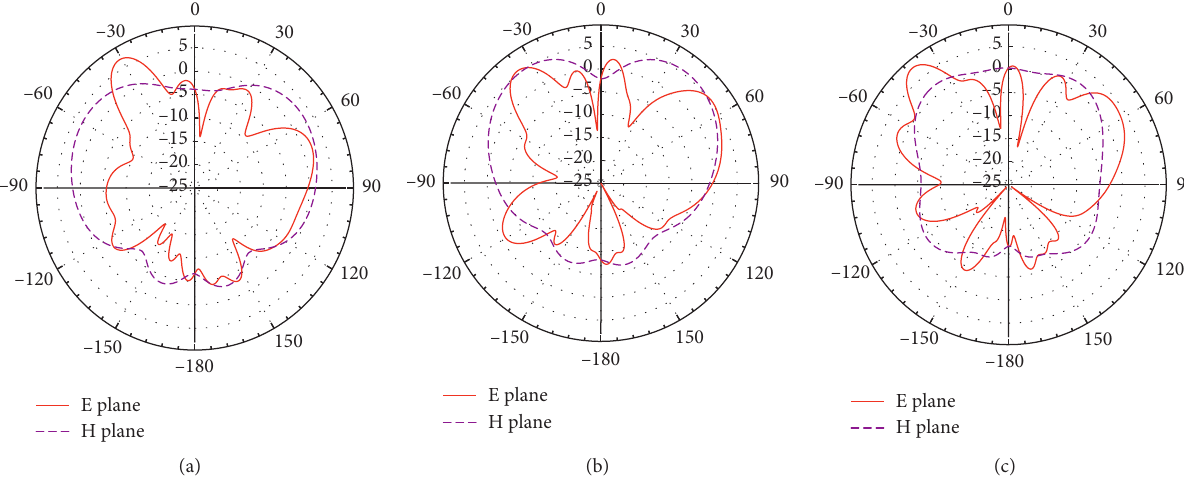
Figure 5: Radiation pattern of series-fed microstrip array antenna: (a) at 26.4GHz, (b) at 28GHz, and (c) at 29.4GHz.